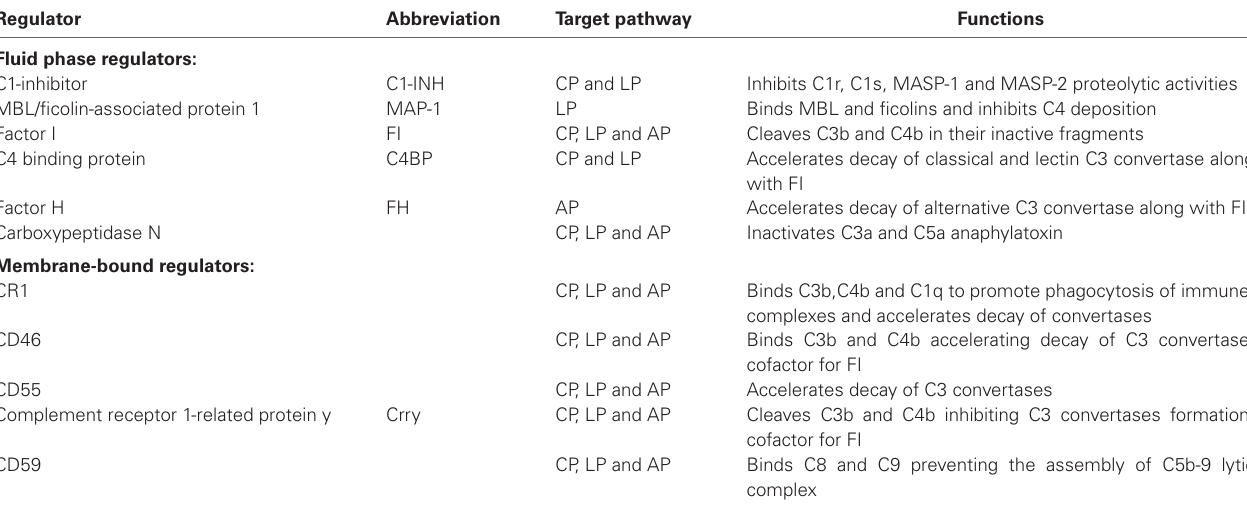
Table 1 | Main complement regulators